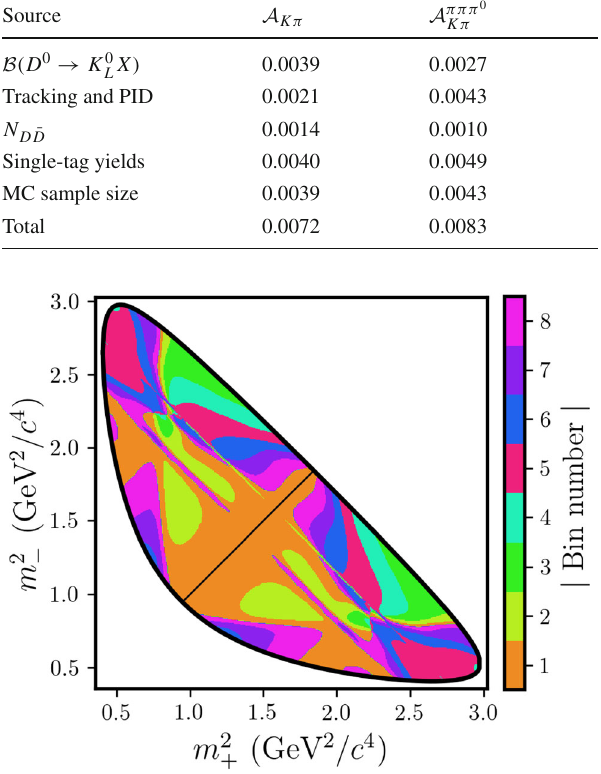
π + π − decays, showing the equal- Δδ S